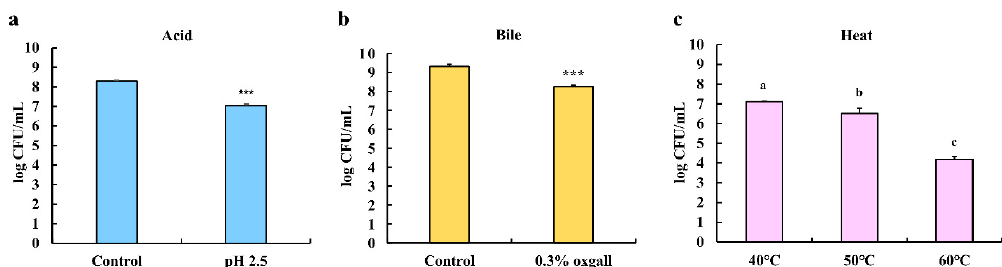
Figure 4. Acid, bile salt, and heat tolerance of LPLB5. The viable cells were counted after exposure to ( a ) pH 6.5 (control) or 2.5 for 4 h ( b ) without (control) or with 0.3% bile salt (oxgall) for 24 h and ( c ) 40, 50, and 60 °C for 1 h. The results represent the mean ± SEM, with n = 3. *** ( p < 0.001) indicates a significant difference vs. control. The different letters on the error bars indicate statistically significant differences between the groups ( p < 0.05).